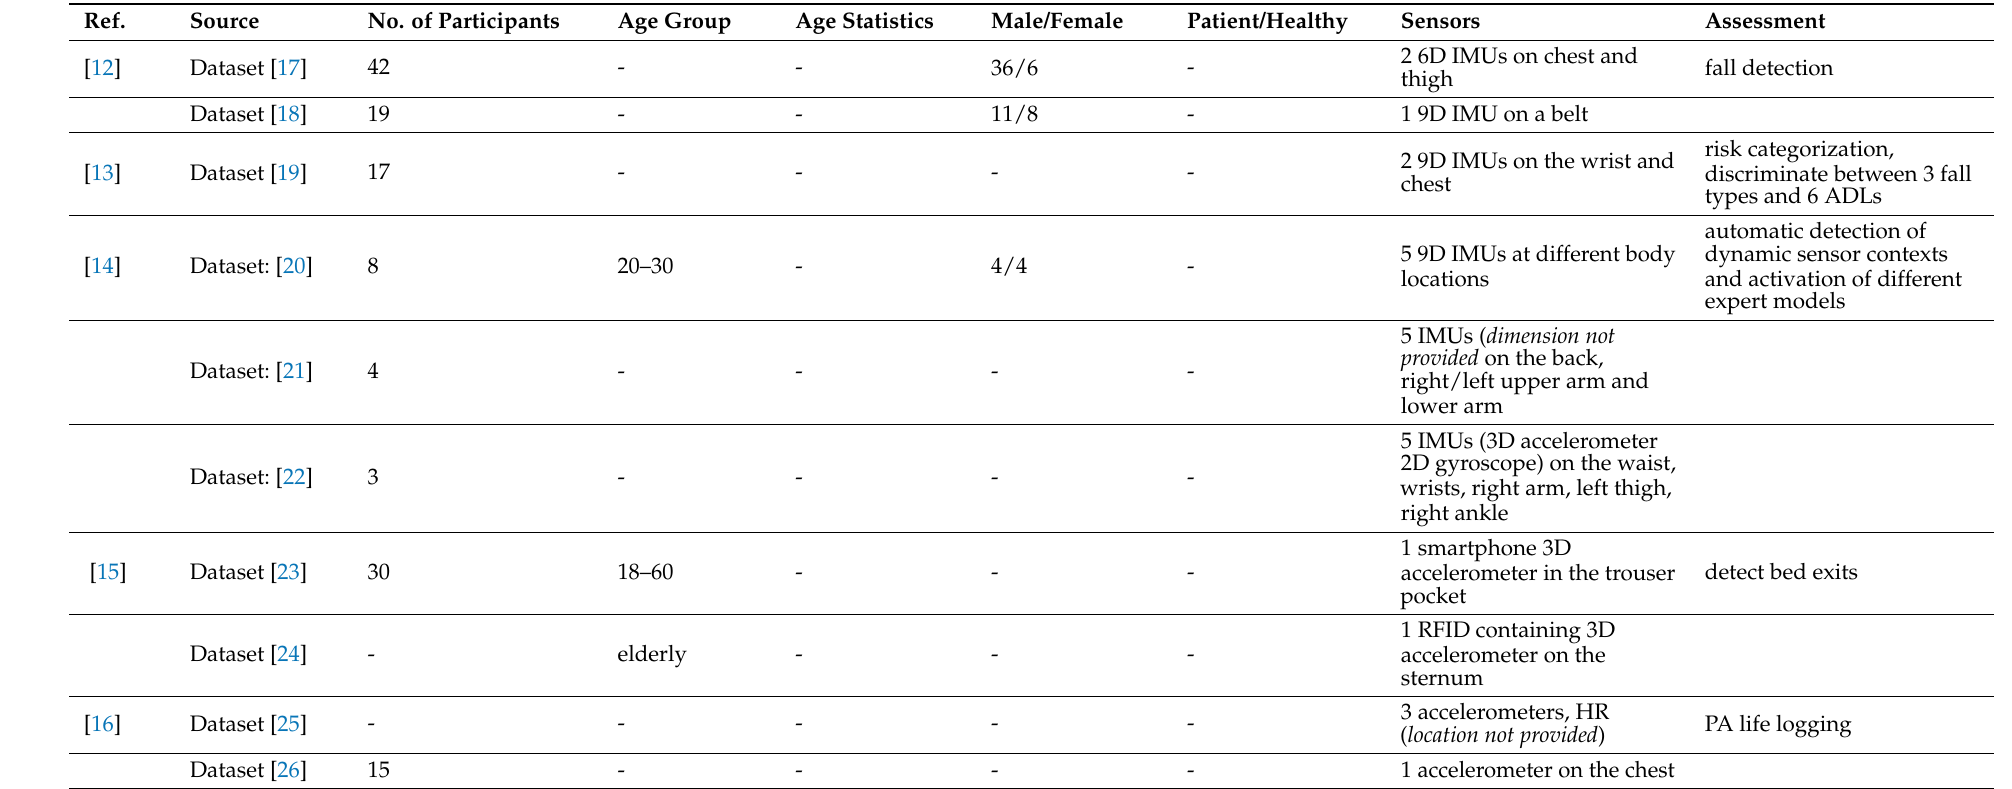
Table A1. Information on demographics and study characteristics for included articles based on